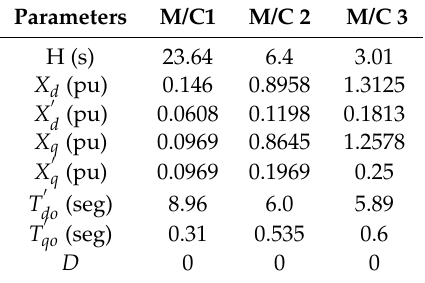
Table A2. Data from the machines of the system.